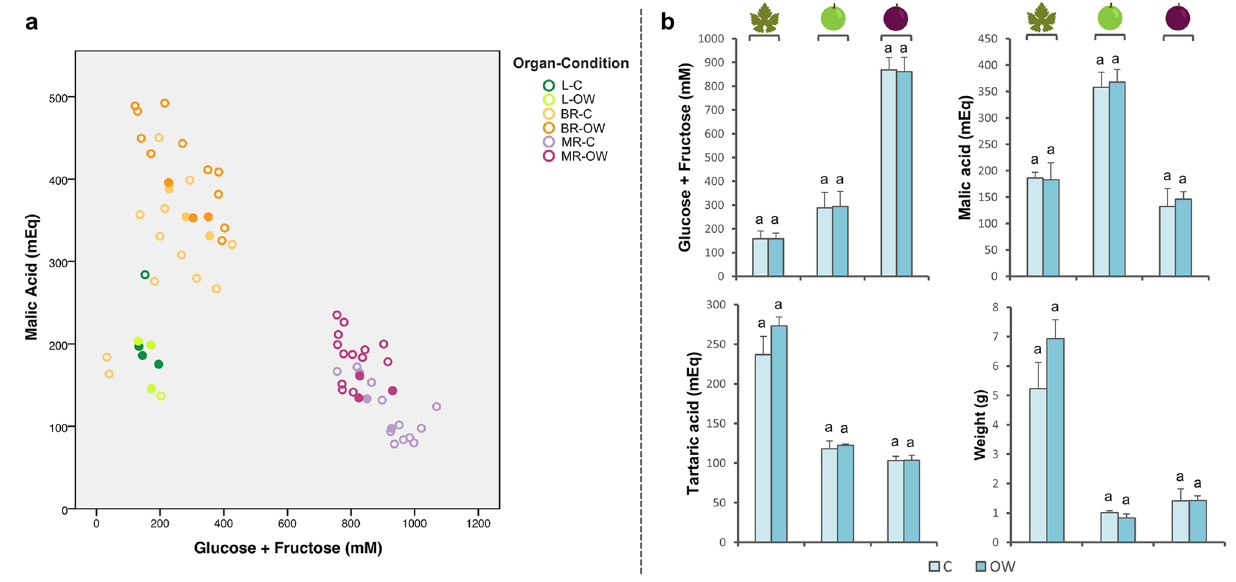
Figure 1. Sugar and acid content and organ fresh weight. ( a ) Malic acid (mEq) as a function of sugar (glucose + fructose, mM). Full coloured circles represent the individual berry or pairs of leaves selected for RNA-Seq; ( b ) Average concentrations in glucose + fructose (mM), malic acid (mEq), tartaric acid (mEq), and organ fresh weight (g) of the selected triplicates. Error bars represent the SD (n = 3). Selected samples showed